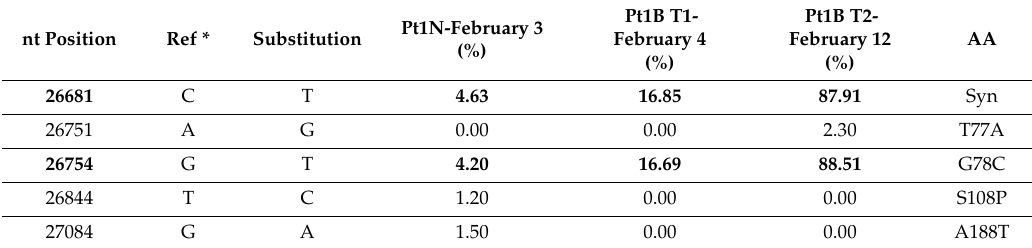
Table 3. Nucleotide positions harboring substitution in the membrane protein of respiratory samples from Patient